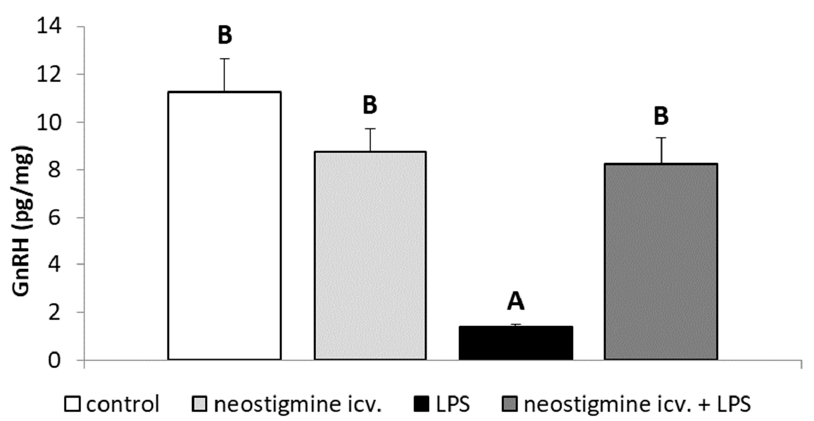
Figure 4. E ff ect of lipopolysaccharide (LPS; 400 ng / kg; intravenous) and neostigmine (1 mg / animal; intracerebroventricular (icv.)) injections on the content of gonadotropin-releasing hormone (GnRH) in the preoptic area of the hypothalamus in the ewes during the follicular phase of the estrous cycle. The Significant di ff erences marked with di ff erent capital letters were analyzed by a two-way